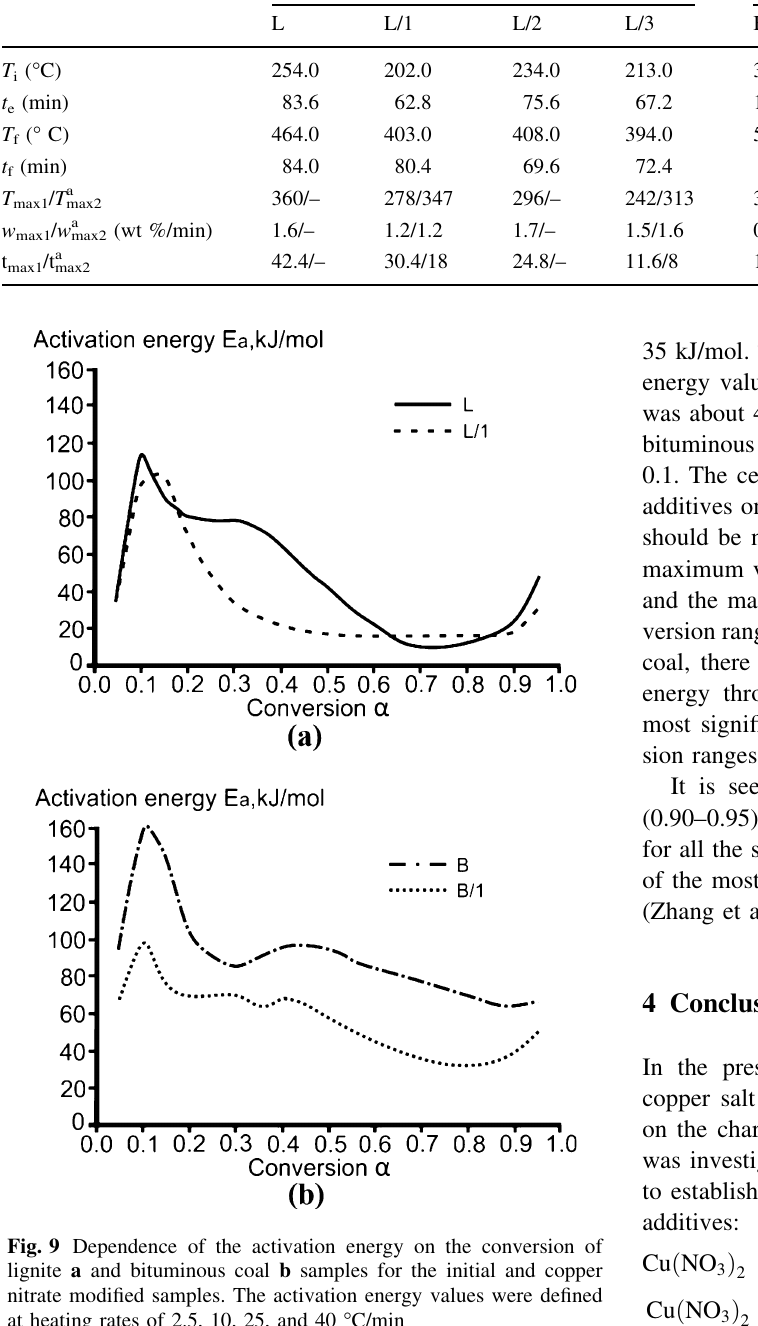
Table 4 Characteristics of the lignite and bituminous coal oxidation using copper salt additives calculated from TG data. The flow rate is 60 mL/ min (air); the heating rate is 2.5 (cid:3) C/min; the temperature range is 45–600 (cid:3) C; the sample loading is about 17 mg Parameter